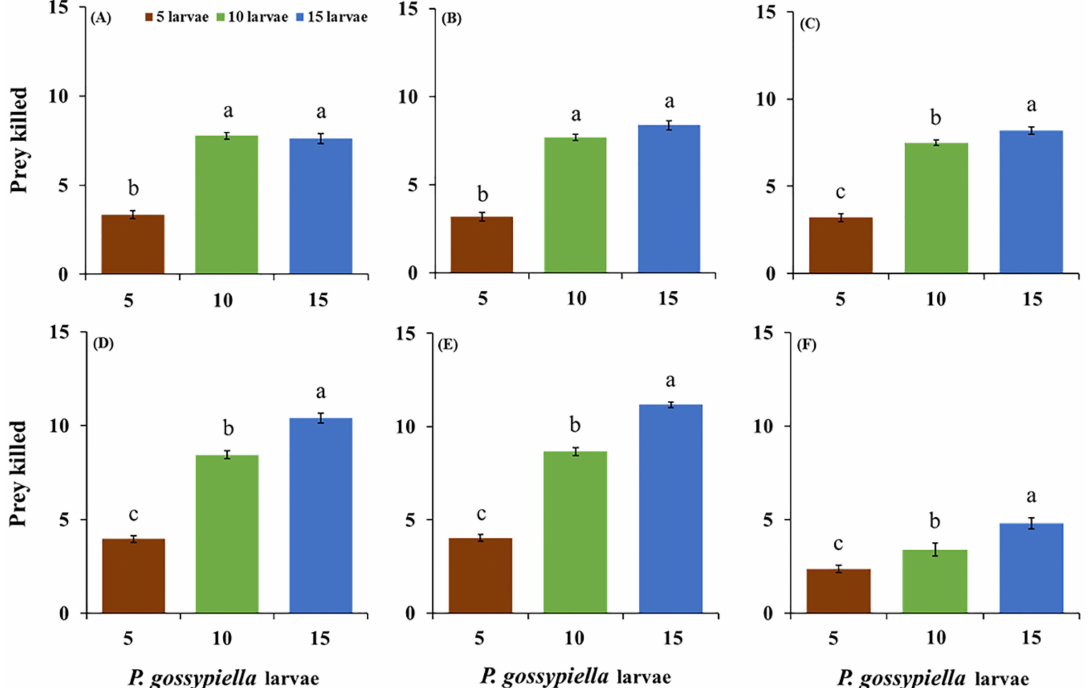
Figure 3. Feeding potential of the predatory stages of the O. strigicollis on three di ff erent densities of P. gossypiella first instar larvae (5, 10, and 15) after 24 h, ( A ) = 3rd instar, ( B ) = 4th Instar, ( C ) = 5th Instar, ( D ) = Male, ( E ) = Female, ( F ) = Control. Di ff erent letters above each bar indicate significant di ff erences between three treatments using one-way ANOVA, LSD test, p = 0.05 and n =